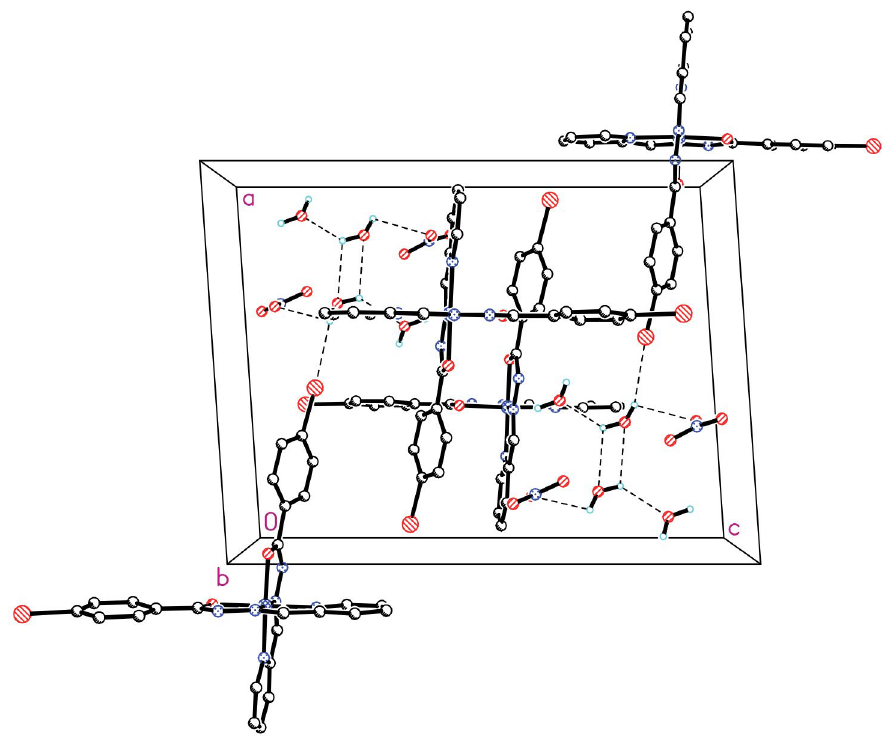
Figure 4. Molecular packing diagram of complex 1 , viewed along the b axis. Hydrogen bonds are shown as dashed lines.